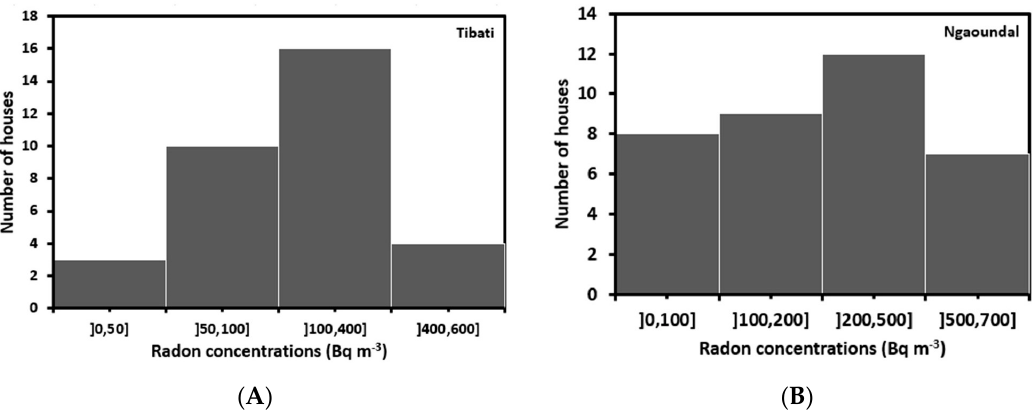
Figure 2. Distribution of radon in dwellings of Tibati ( A ) and Ngaoundal ( B ) using EPERM